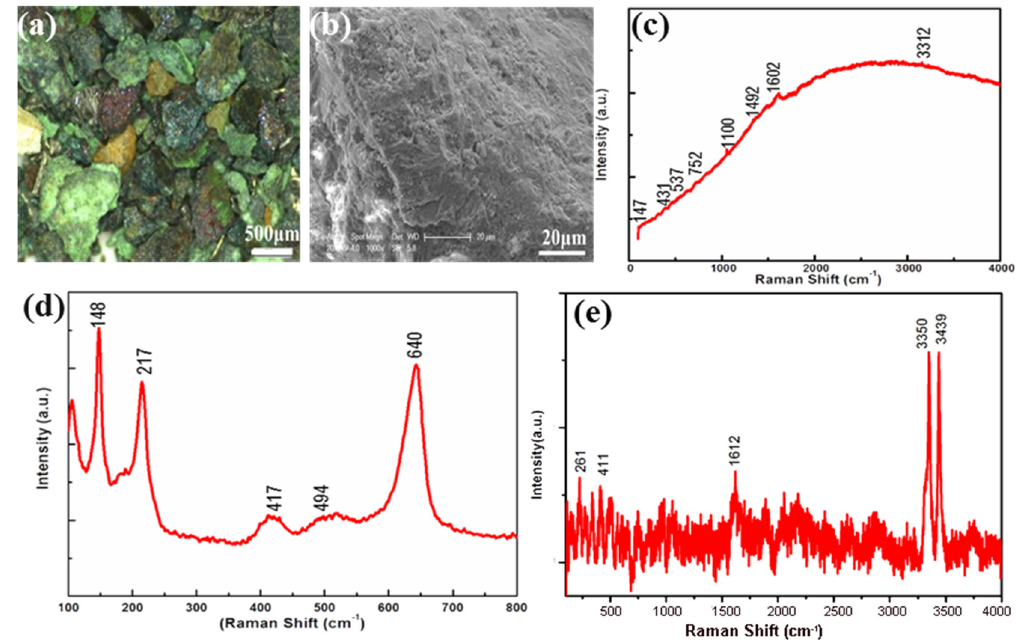
Figure 6. Characterizations of the corrosion products upon the bronze sword (Western Han Dynasty, collection No.: 1938): ( a ) Optical image; ( b ) SEM morphology; ( c ) Raman spectrum of malachite in a range 100–3500 cm − 1 ; ( d ) Raman spectrum of cuprite in a range 100–800 cm − 1 ; ( e ) Raman spectrum of atacamite in a range 100–4000 cm − 1 .